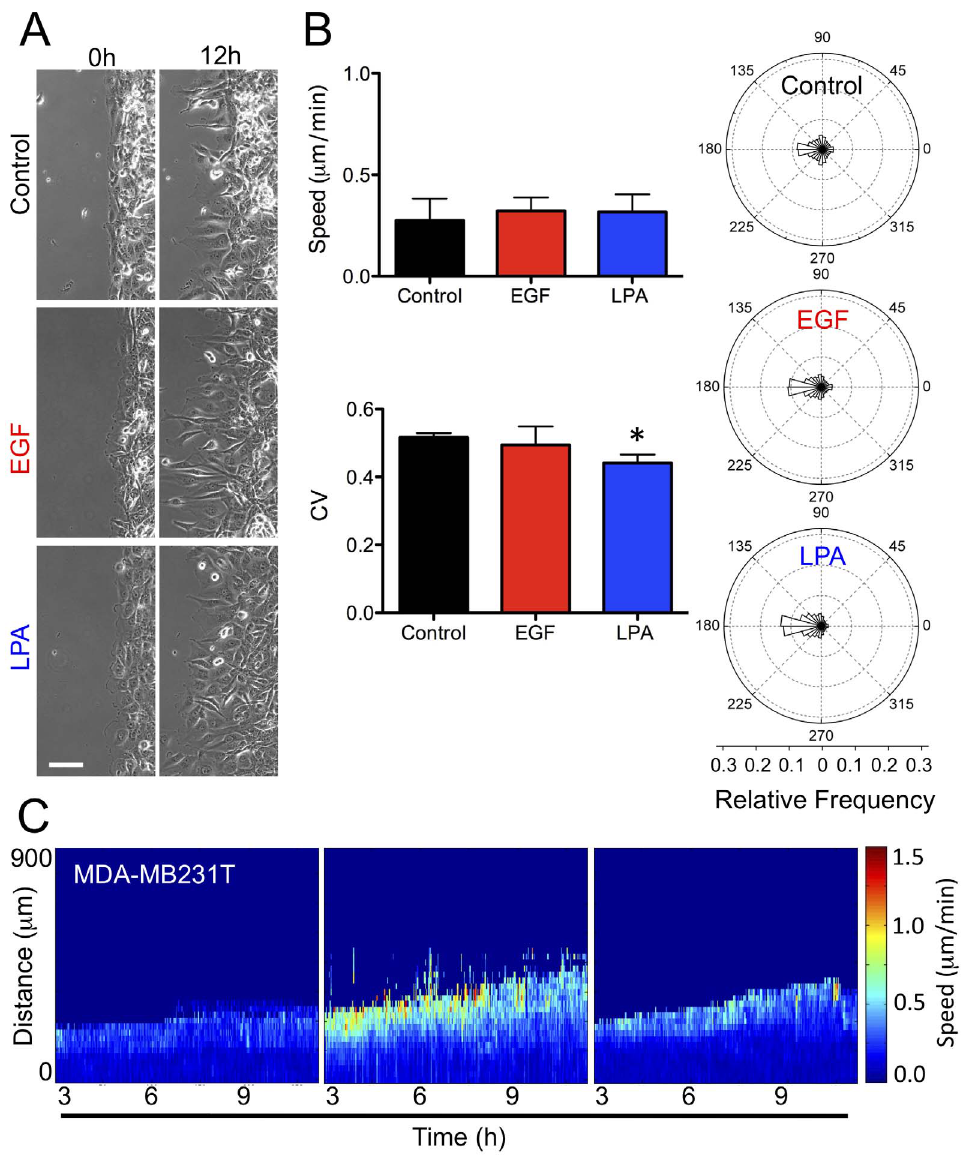
Figure 5. The migratory phenotype of MDA-MB 231T is similar to that of M4 cells. ( A ) Phase contrast images of MDA-MB-231T cells moving into open space after 12 h under control (Black), 5 ng/mL EGF (red), and 1 m M LPA (blue) treatments. Bar=100 m m. ( B ) Right: The effects of EGF and LPA treatment on average speed (top) and directionality, CV (bottom) determined over all times and space, were compiled from 5–6 independent experiments and reported as mean 6 SD. Left: Aggregate directionality profiles for control, EGF and LPA conditions. Statistical significance: *p , 0.05 (Tukey-Kramer test, n=3). ( C ) Representative spatiotemporal heat plots show speed responses in control, EGF, and LPA treated cells. See Fig. 4 for details.